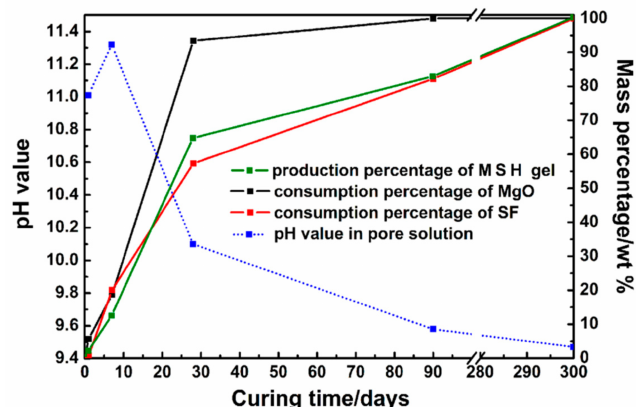
Figure 11. Consumption percentage of MgO/SF and production percentage of MSH gel in MSH samples cured for 300